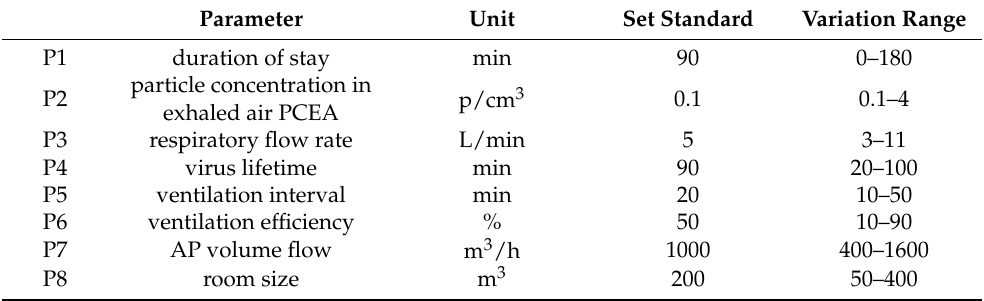
Table 4. Overview of the investigated influence parameters with the set standard values and the belonging variation